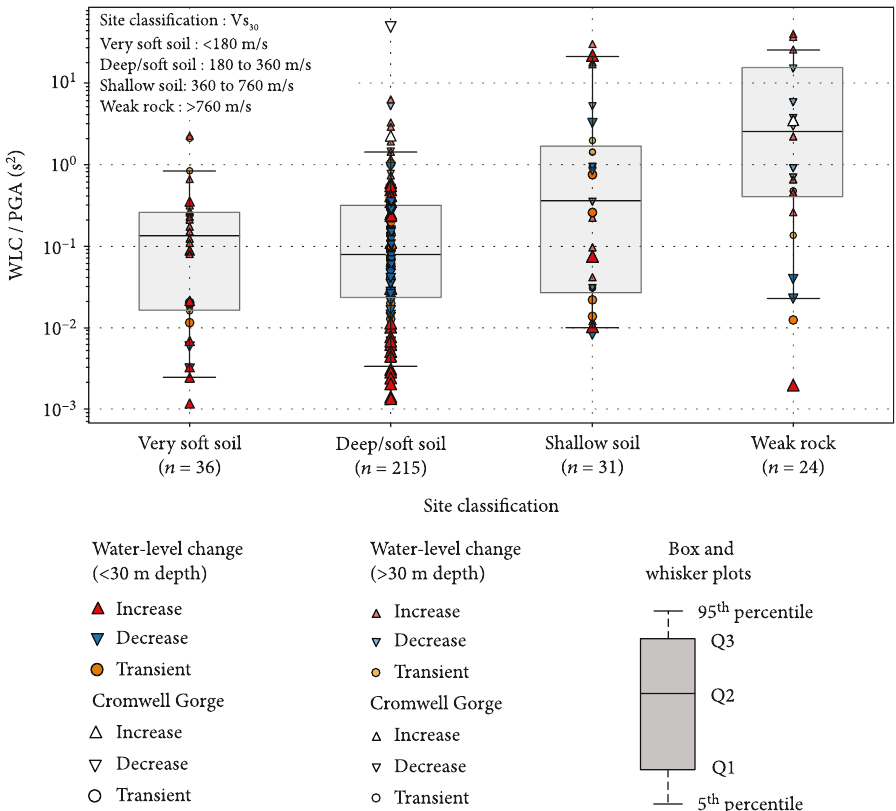
Figure 10: WLC/PGA as a function of site classi fi cation [78]. Site classi fi cations are converted from Vs shallower than 30m have larger opaque symbols as Vs is representative. Monitoring well depths deeper than 30m have smaller 30 transparent symbols as Vs is less 30